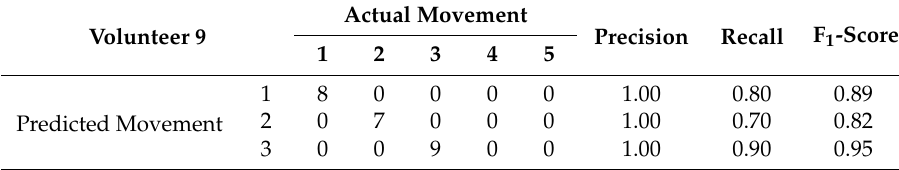
Table A9. Results Volunteer 9.